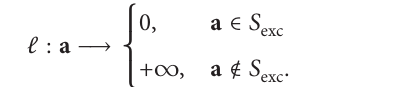
Algorithm 1 (iterative procedure for optimum pattern scaling factor ̃𝛼